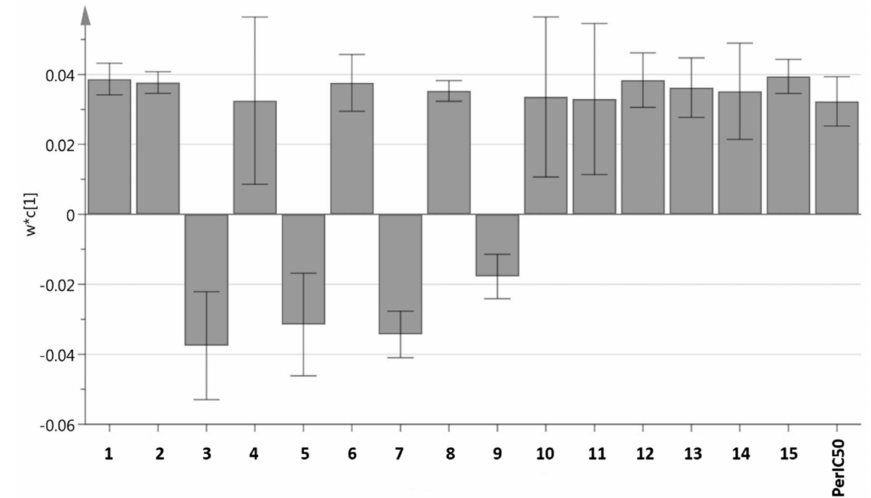
Figure 4. PLS loading column plot of different solvent extracts of C. nutans leaves.